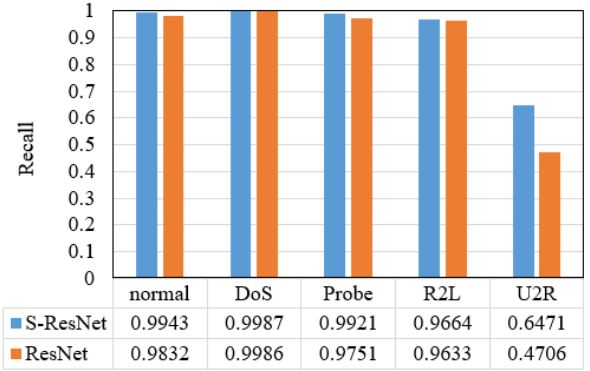
Figure 11. The recall results of the two IDSs for each category.